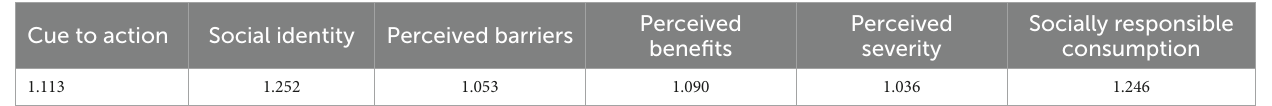
TABLE 5 Lateral collinearity